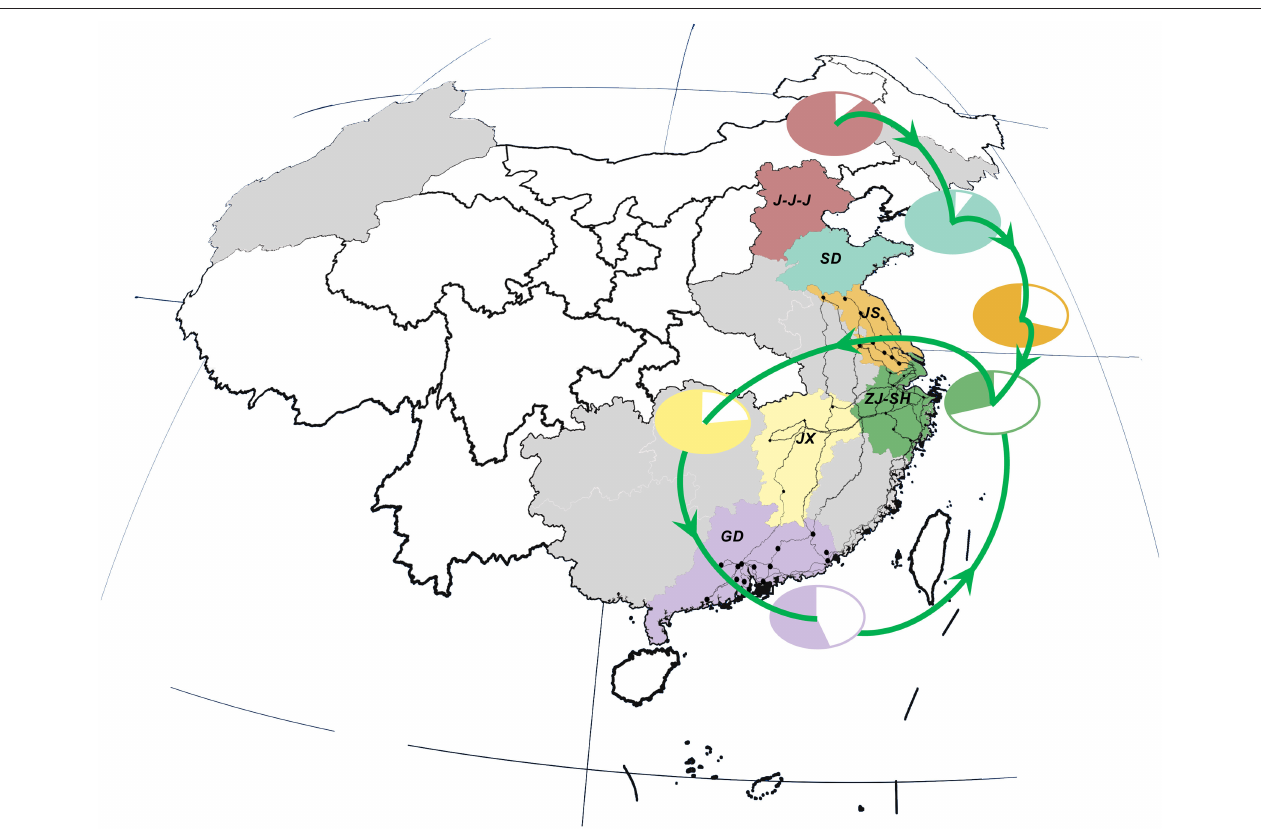
FIGURE 3 | Live poultry transportation network and relative poultry production and consumption in study area. Locations, national roads and cities are colored in consistent with those in Figure 2 . Poultry transmission paths are illustrated in green lines with arrows. The relative percentage of poultry production (color area) and consumption (white area) in each region/province is distinguished by the same color as the corresponding